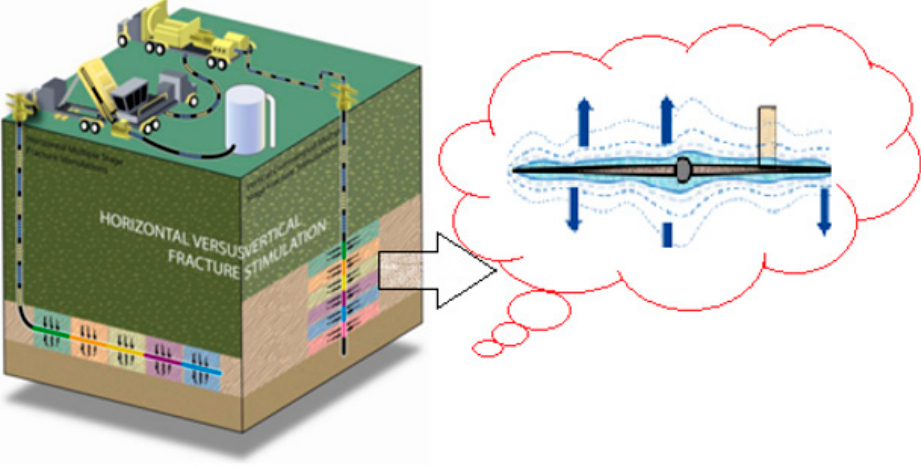
Figure 3. Schematic diagram of hydraulic fracturing in vertical and horizontal wells in a tight sandstone gas reservoir.